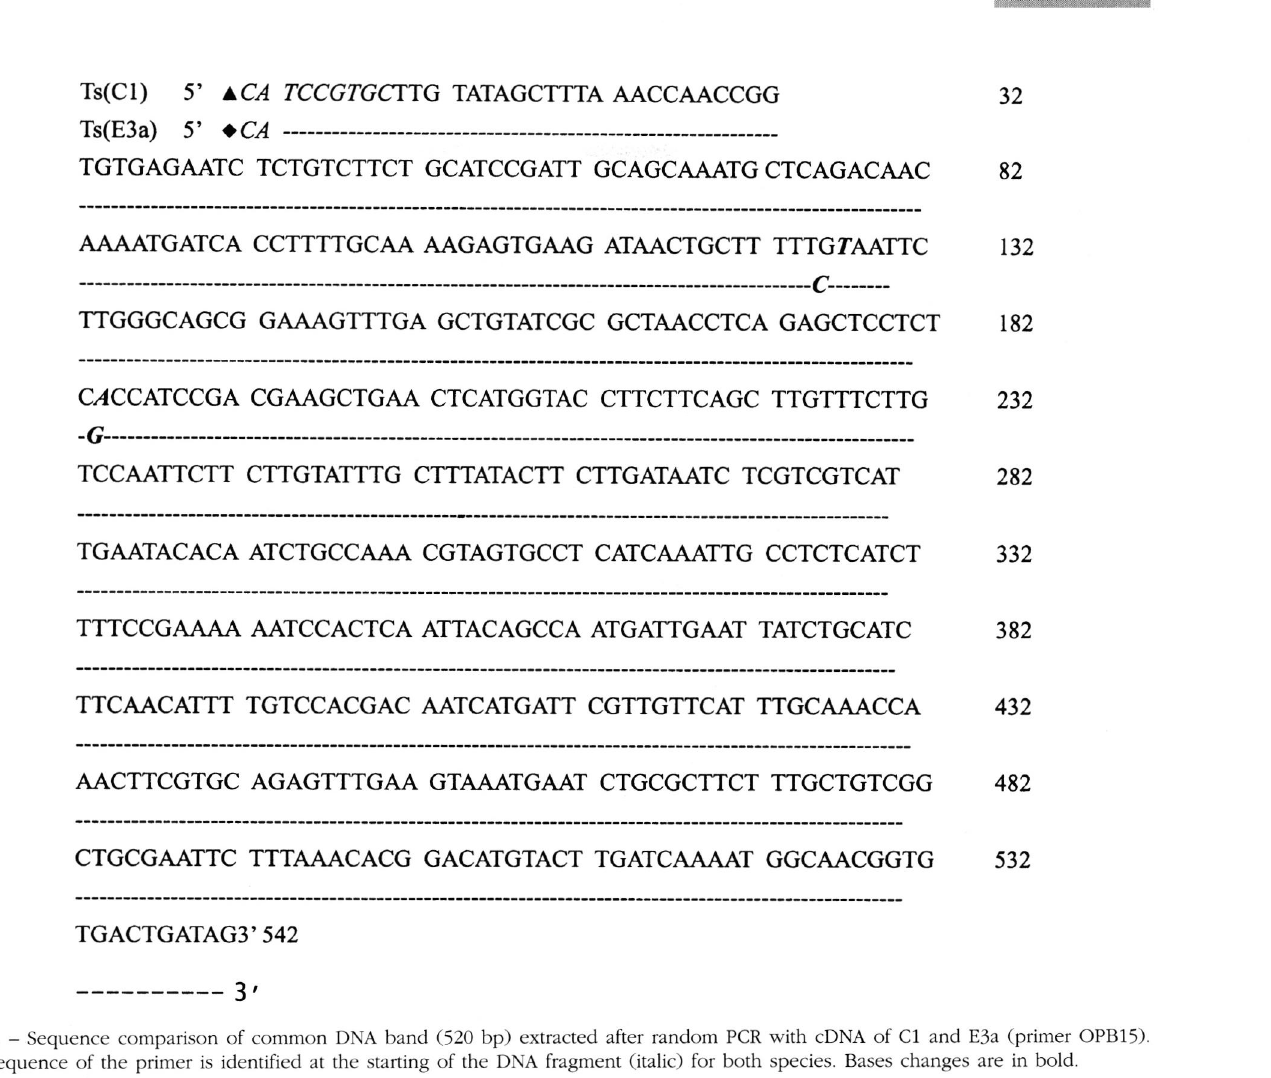
Fig. 3. - Sequence comparison of common DNA band (520 bp) extracted after random PCR with cDNA of C1 and E3a (primer OPB15). The sequence of the primer is identified at the starting of the DNA fragment (italic) for both species. Bases changes are in bold.